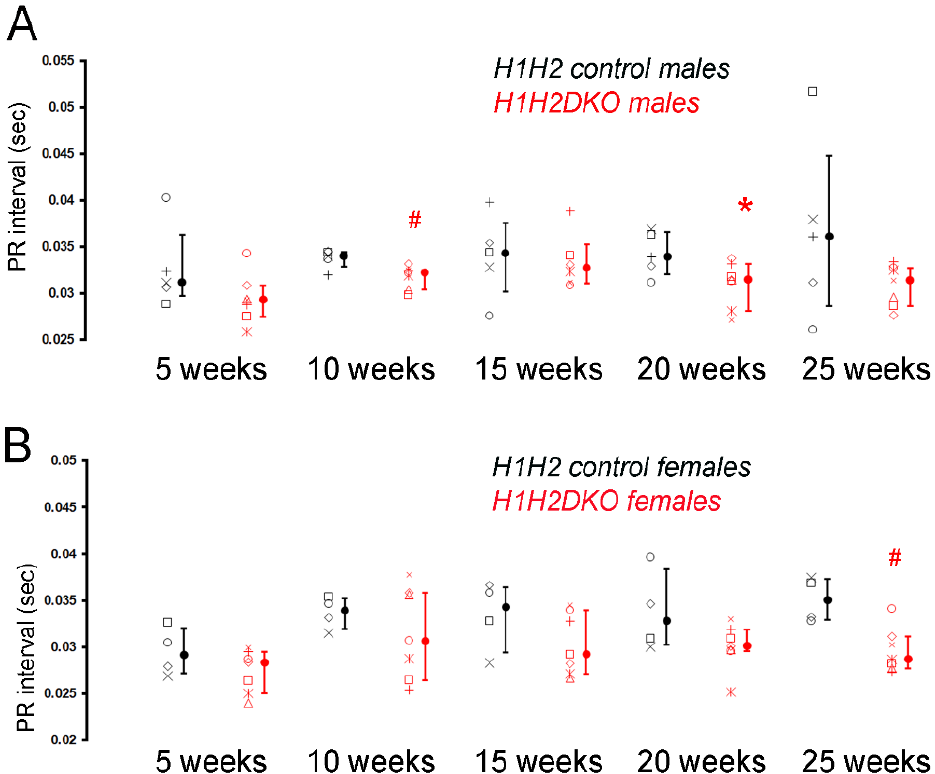
Figure 3. Loss of Hand1 and Hand2 in post-natal CCS results in intermediate phenotype. ( A ) PR intervals (in seconds) in Lead I ECG analysis from male Cntn2 Cre-EGFP/+ ; Hand1 fx/fx Hand2 fx/fx ( H1H2DKO s, open red symbols, n = 7) and Hand1 fx/xf Hand2 fx/fx ( H1H2control , open black symbols, n = 5) male mice at 5-week, 10-week, 15-week, 20-week, and 25-week time points. Identical symbols on the left of each line in graph represent the values of the same individual mouse across time points. Filled circles, medians; error bars, 25th and 75th percentiles. * p < 0.05, # p < 0.01 versus male H1H2control . ( B ) PR intervals (in seconds) in Lead I ECG analysis from female Cntn2 Cre-EGFP/+ ; Hand1 fx/fx Hand2 fx/fx ( H1H2DKO s, open red symbols, n = 7) and Hand1 fx/xf Hand2 fx/fx ( H1H2control , open black symbols, n = 4) female mice at 5-week, 10-week, 15-week, 20-week, and 25-week time points. Identical symbols on the left of each line in graph represent the values of the same individual mouse across time points. Filled circles, medians; error bars, 25th and 75th percentiles. # p < 0.01 versus female H1H2control